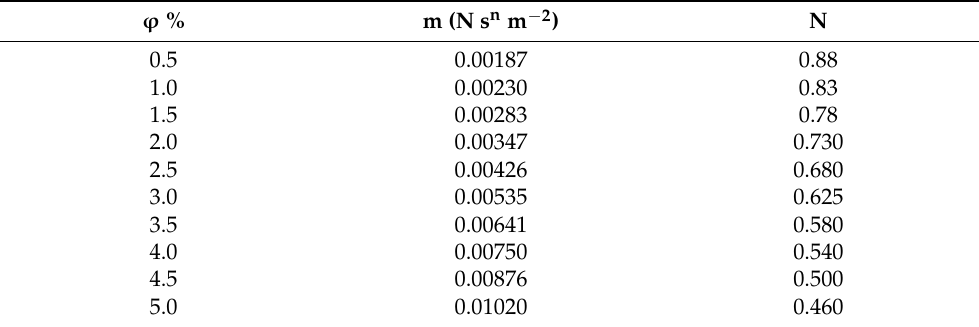
Table 3. Thermal parameters of Al 2 O 3 Nano-non-Newtonian, reproduced with permission from [23,24].